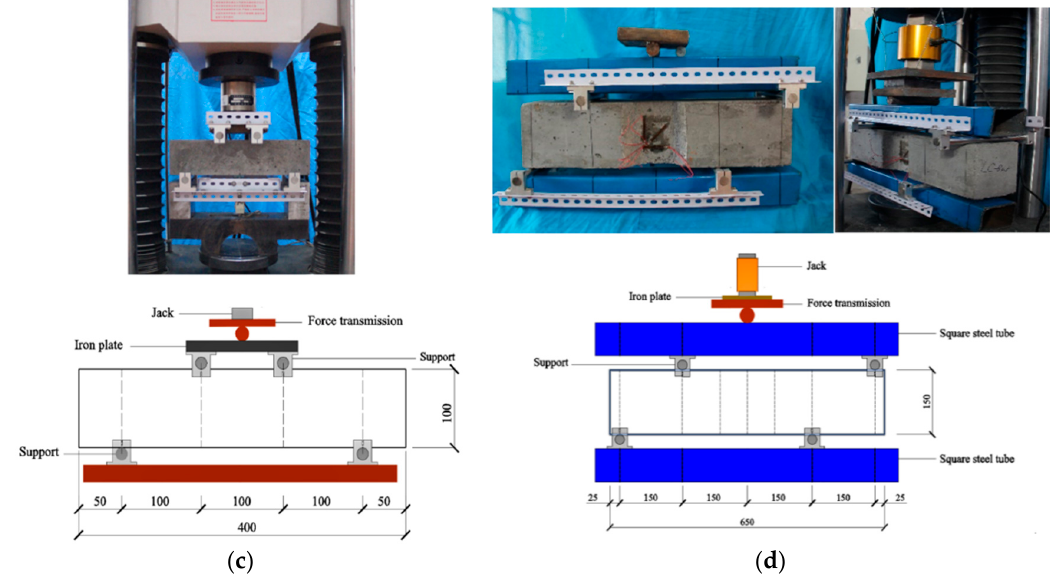
Figure 2. Test methods and size of test samples for—( a ) cube compressive strength, ( b ) splitting tensile strength, ( c ) flexural strength, ( d ) shear strength. (The unit value of four figures are mm)